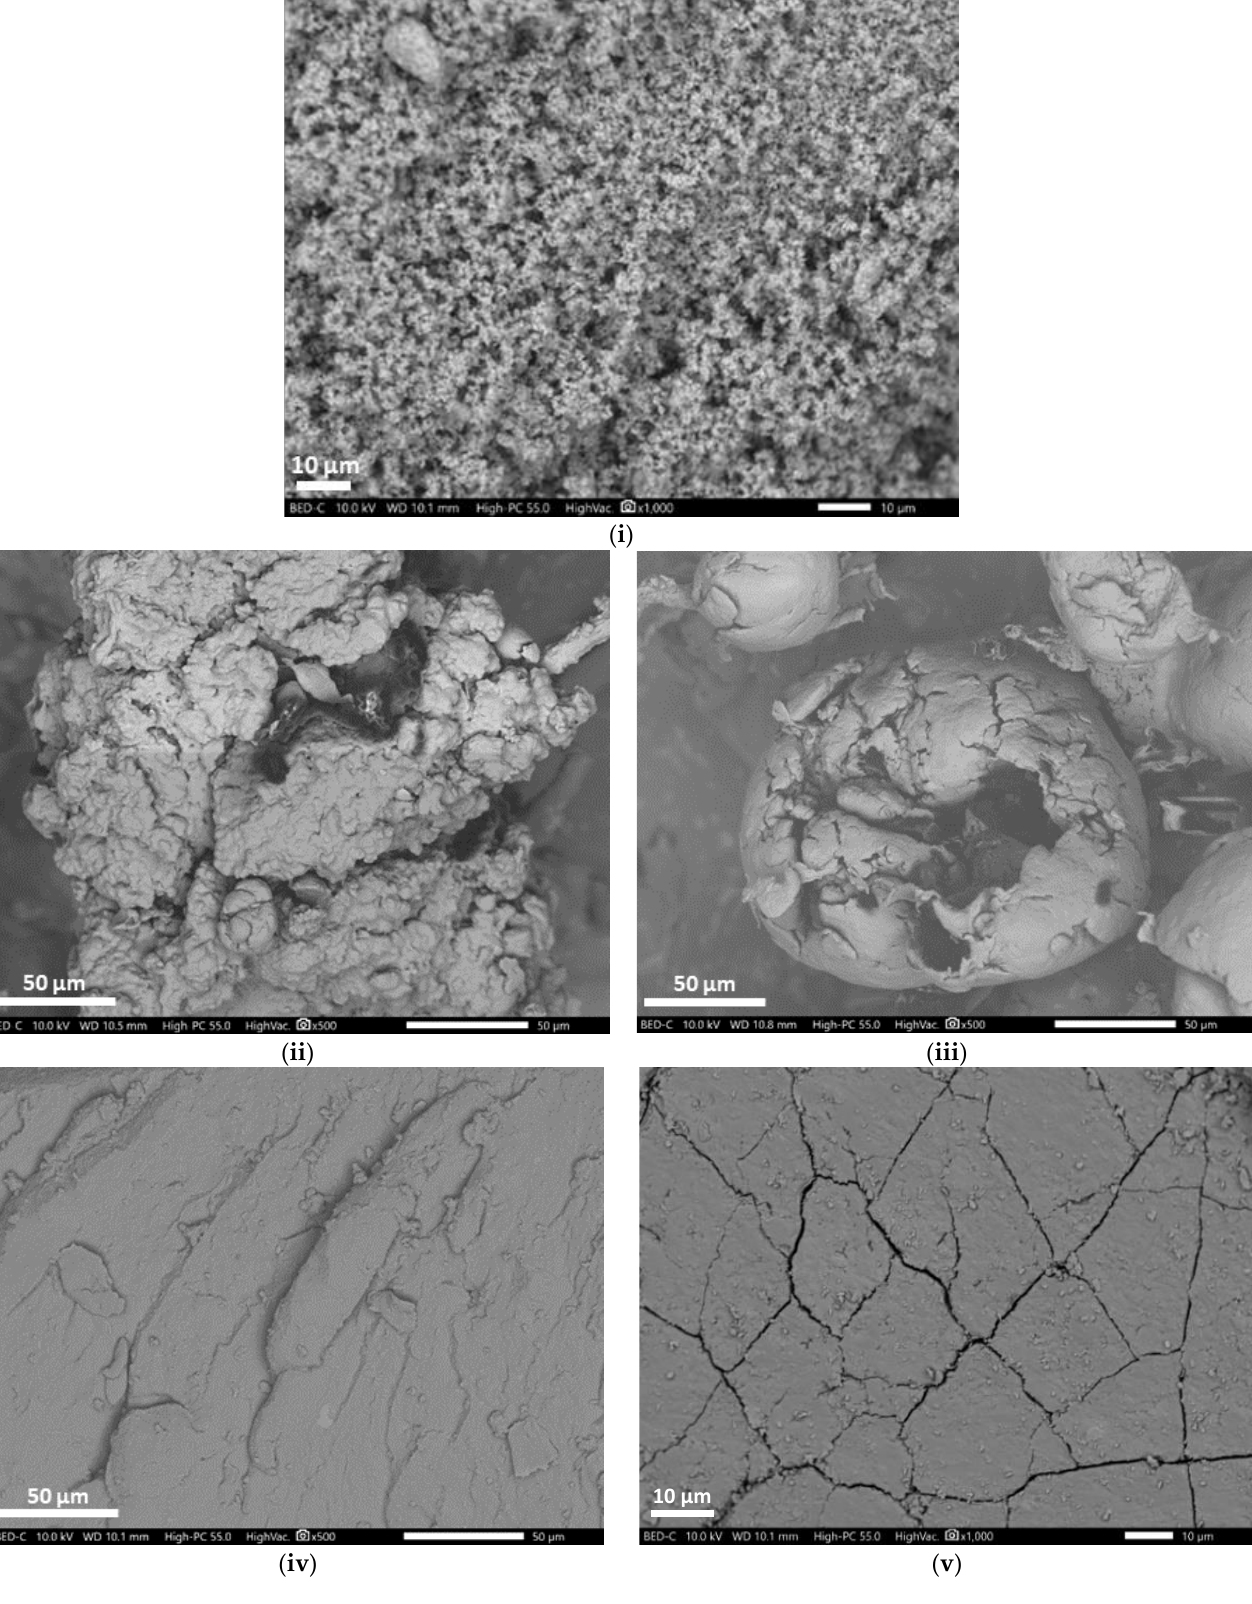
Figure 3. SEM of ( i ) Fe@SiO 2 /MDOS ( ii ) PE ( iii ) Weathered PE 1000h ( iv ) TWP ( v ) Weathered TWP 1000h